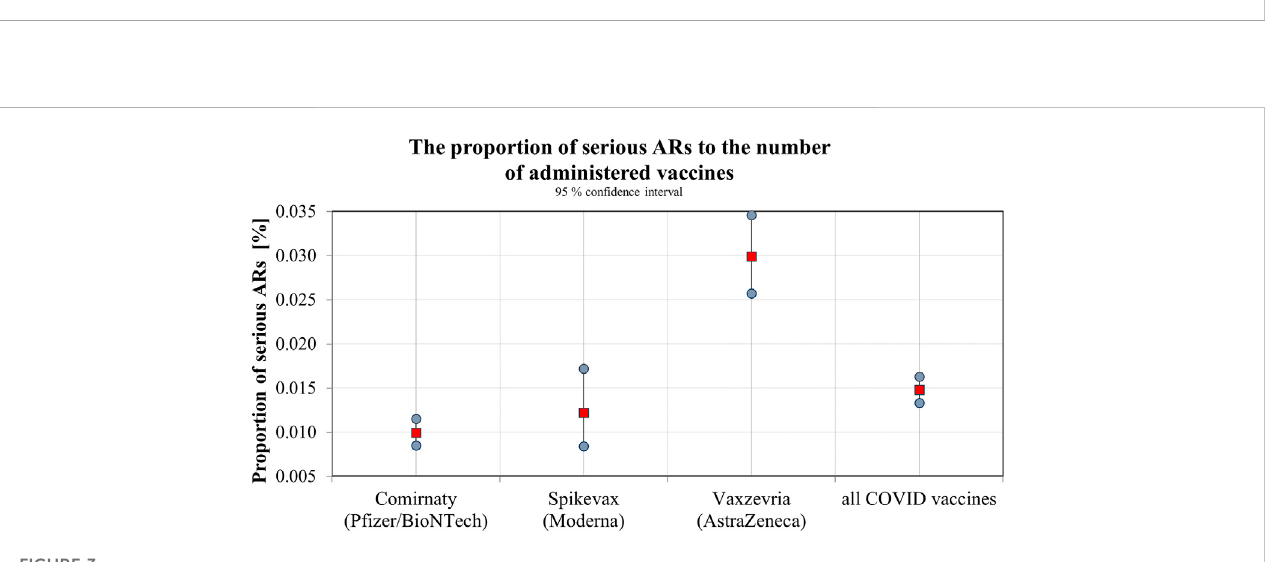
The proportion of serious ARs to the number of administered vaccines.